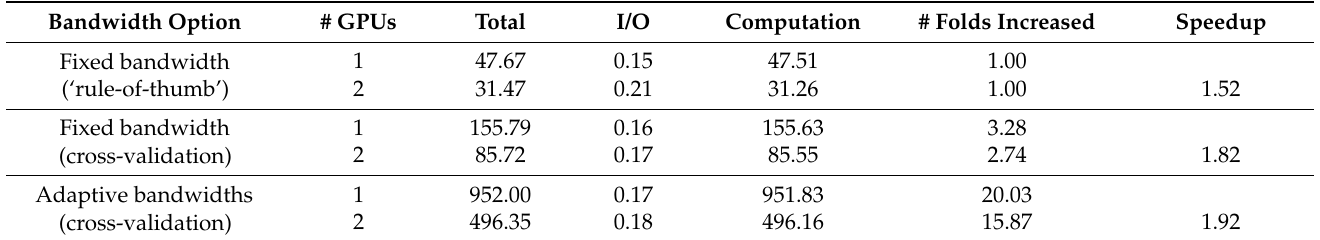
Table 4. Execution time (in seconds) for density estimation with three bandwidth options on a syn-